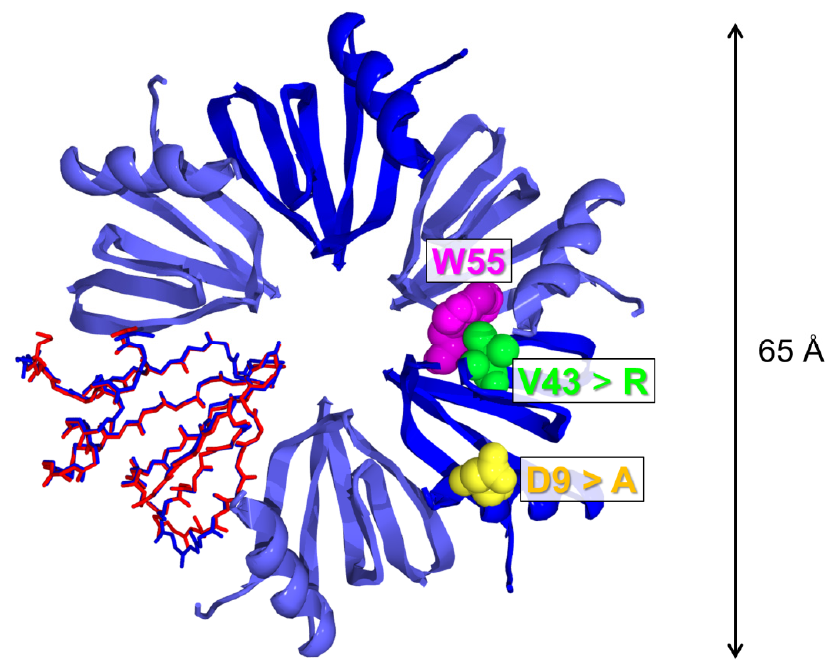
Figure 1. The crystal structure of the Hfq Y55W mutant: the tryptophan residue (W55) inserted into the hexameric structure and additional mutations (V43R, D9A) serving to obtain the protein monomeric form are shown in rectangles. One subunit represents the superposition of the subunit main chain conformations for the WT (red, PDB code 1U1T) and Y55W (blue, PDB code 5I21) Hfq variants. The double arrow to the right of the figure shows the external diameter of the protein ring.